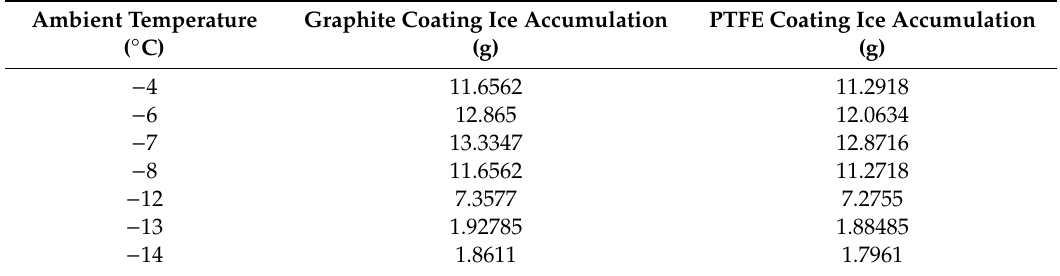
Table 5. Ice accumulation for various ambient temperatures.